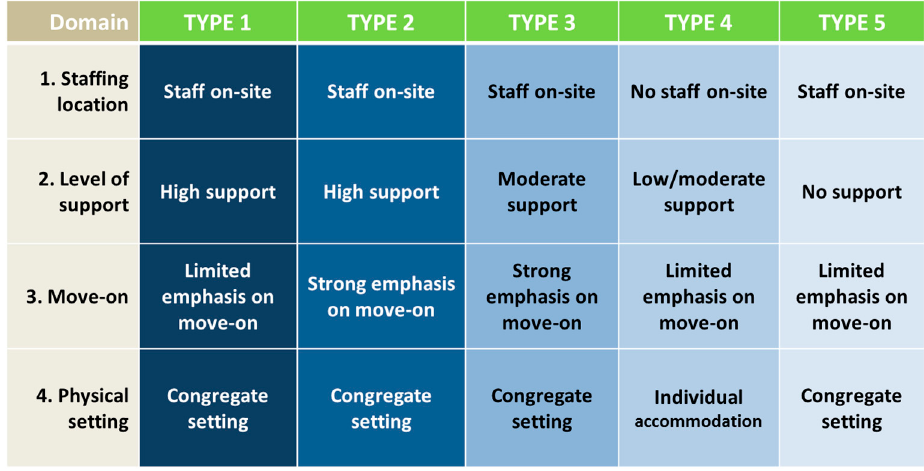
Figure 1. Final structure of the STAX ‐ SA.